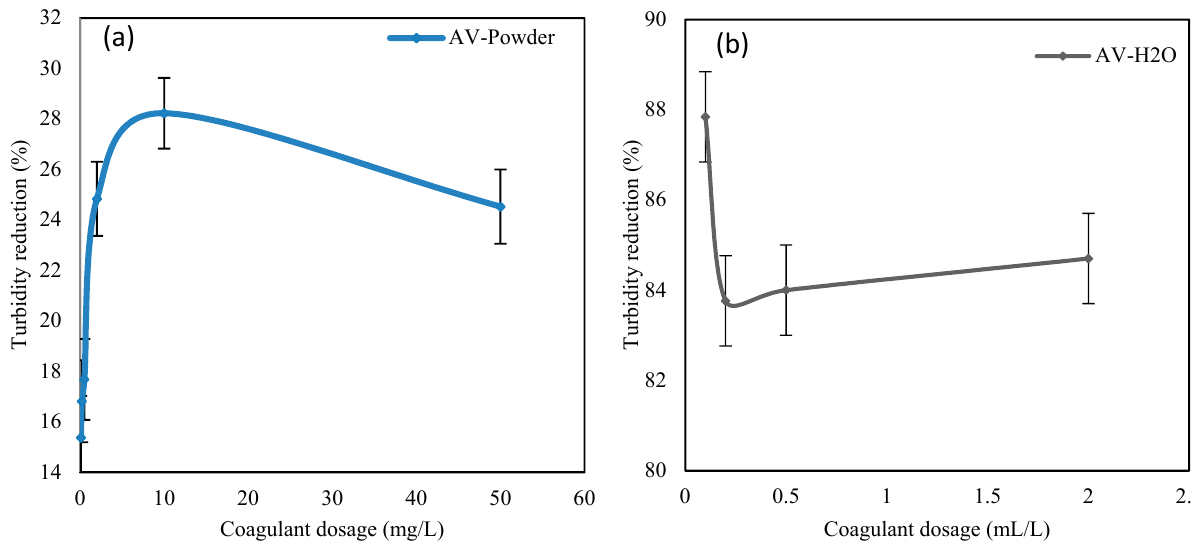
Figure 5. Effect of bio-coagulant dosage on water turbidity reduction by using: ( a ) AV Powder; ( b ) AV-H 2 O.